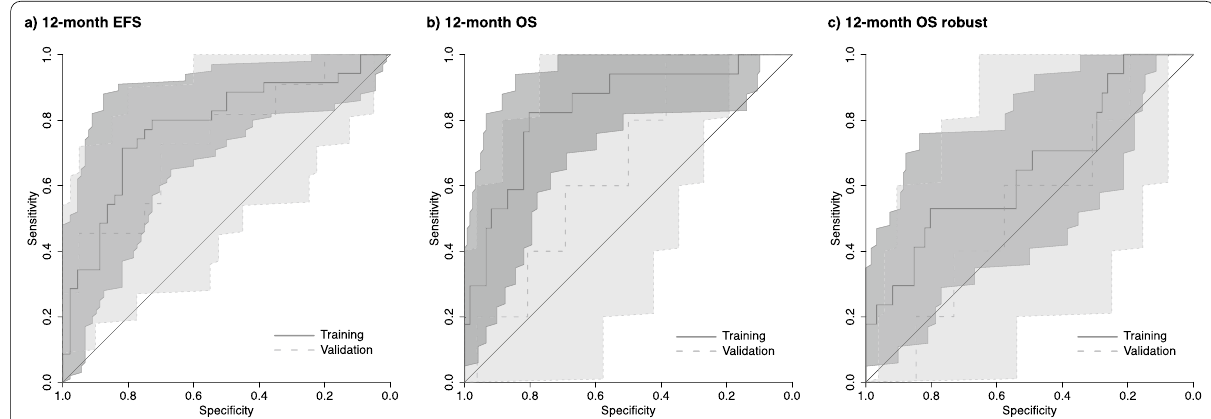
Fig. 4 ROC curves. Receiver operating characteristic (ROC) curves with 95%‑CI for a 12‑month EFS, b 12‑month OS and c robust 12‑month OS for training (dark grey, solid lines) and validation cohorts (light grey, interrupted lines) are shown. Only the 12‑month EFS model trained on the entire feature set without robust preselection was successful in the validation